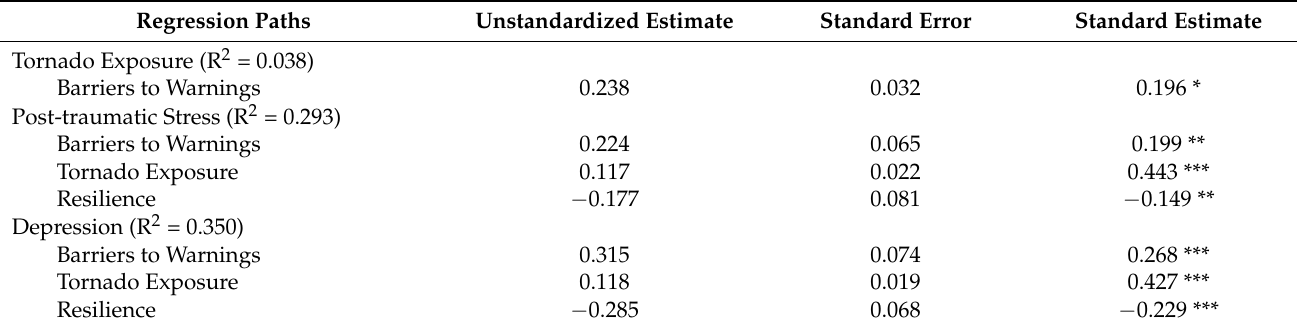
Table 2. Structural model: regression